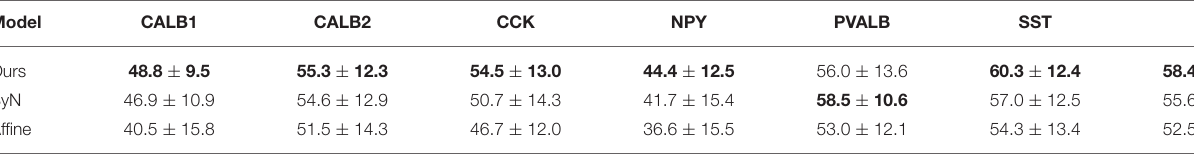
TABLE 3 | Summary of results on a gene-holdout split (Dice-8, mean, and standard deviation in percentage). Model